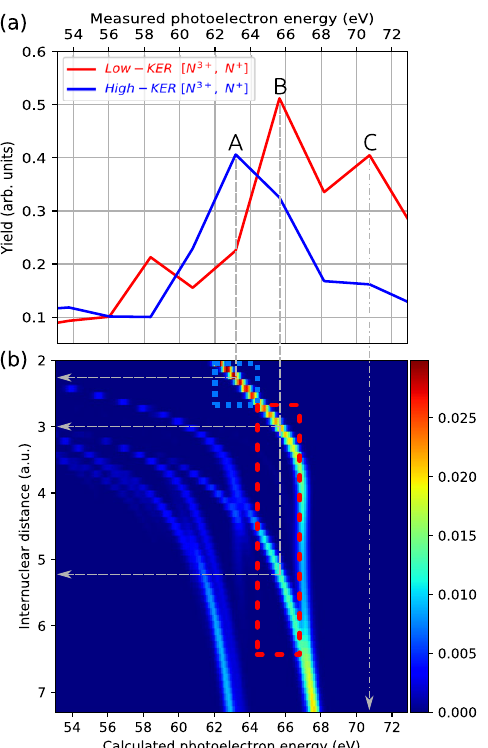
Figure 6. Dynamic photoelectron line shift. ( a ) Experimental photoelectron kinetic energy spectra from Fig. 5, but zoomed into the energy range from 53 eV to 73 eV, corresponding to electrons emitted from N second photoabsorption step. ( b ) Calculated photoelectron kinetic energy spectra of N internuclear distance. The color encodes the relative probability for a N for a given internuclear distances. The vertical gray dashed lines mark the peak positions (A, B and C) observed in the experimental spectra. The horizontal lines indicate the internuclear distances at which the vertical dashed lines cross the calculated photoelectron lines. The vertical dashed lines at peak C also crosses the calculated photoelectron line, but only at the internuclear distance larger than the range shown in the figure. The calculated photoelectron energy at larger internuclear distances are shown in Fig. 7. The blue and red dashed rectangles mark the regions centered at photoelectron energies of peaks A and B, respectively, with a width corresponding to the experimental energy bin size of 2.5 eV.